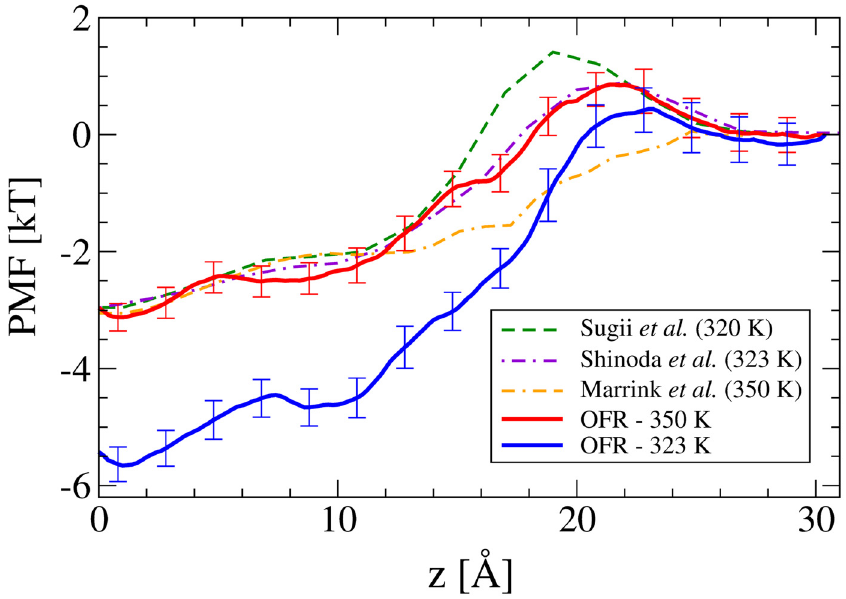
Fig 4. The PMF of O 2 shown together with previously published curves, in units of kT for the most relevant comparison at different temperatures. The bilayer center is at z = 0 and the bulk solution begins at z = 30 Å . The error bars represent two standard errors.